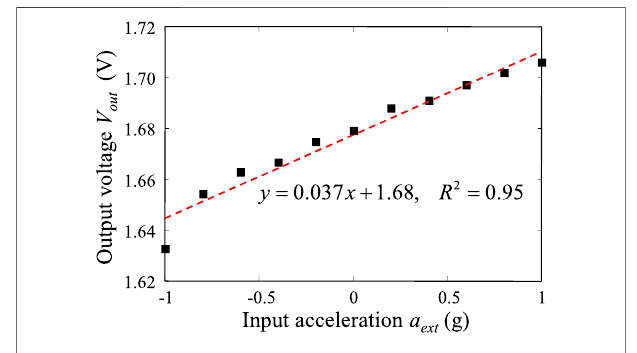
FIGURE 11 | Static acceleration test.